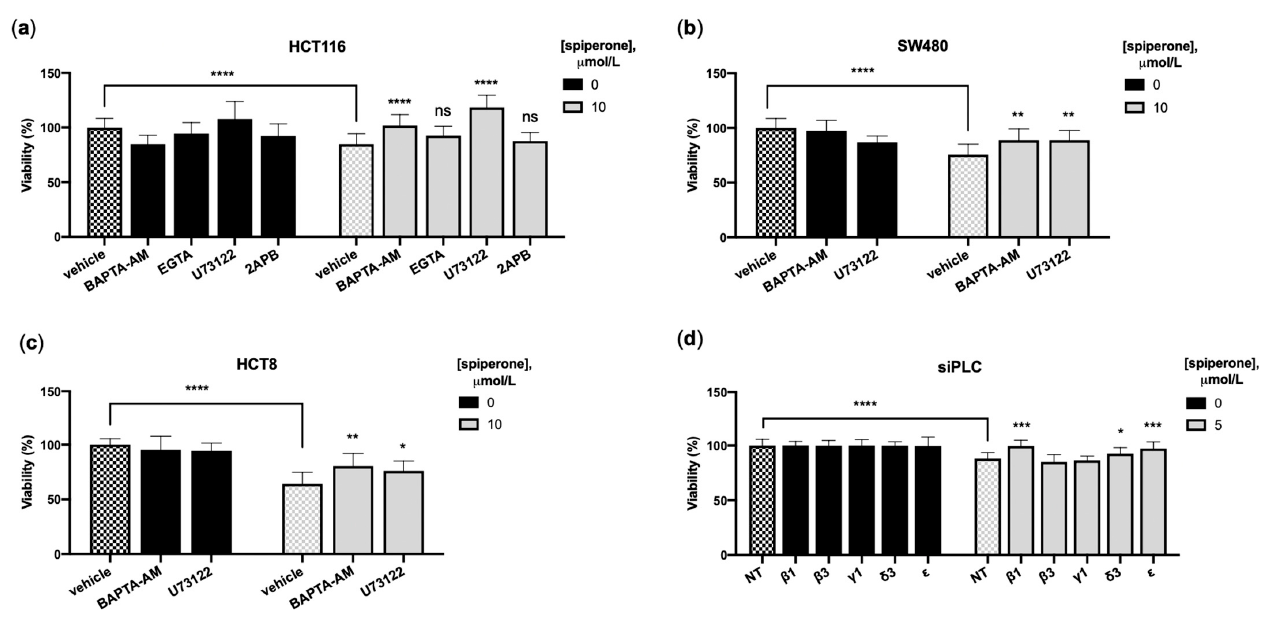
Figure 5. Spiperone induces Ca 2+ and PLC-dependent cell death. Effect of co-treatment with spiperone and 1 μ mol/L BAPTA-AM, 1 μ mol/L EGTA, 2 μ mol/L U73122, and 10 μ mol/L 2APB in HCT116 cells. After 30 min of pretreatment, cells were co-treated with 10 μ mol/L spiperone or vehicle for 24 h ( a ). Effect of co-treatment with spiperone and 1 μ mol/L BAPTA-AM or 2 μ mol/L U73122 in SW480 ( b ) and HCT8 cells ( c ). After 30 min of pretreatment, 10 μ mol/L spiperone or vehicle were added, and co-treatment was maintained for 24 h. Effect of PLC silencing on spiperone-induced cell death. HCT116-silenced cells were treated for 48 with 5 μ mol/L spiperone ( d ). Graphs displaying cell viability as the percentage of viable cells. Data show the mean ± SD of at least three independent experiments performed in triplicate. *: Student’s t -test p < 0.05; **: Student’s t -test p <